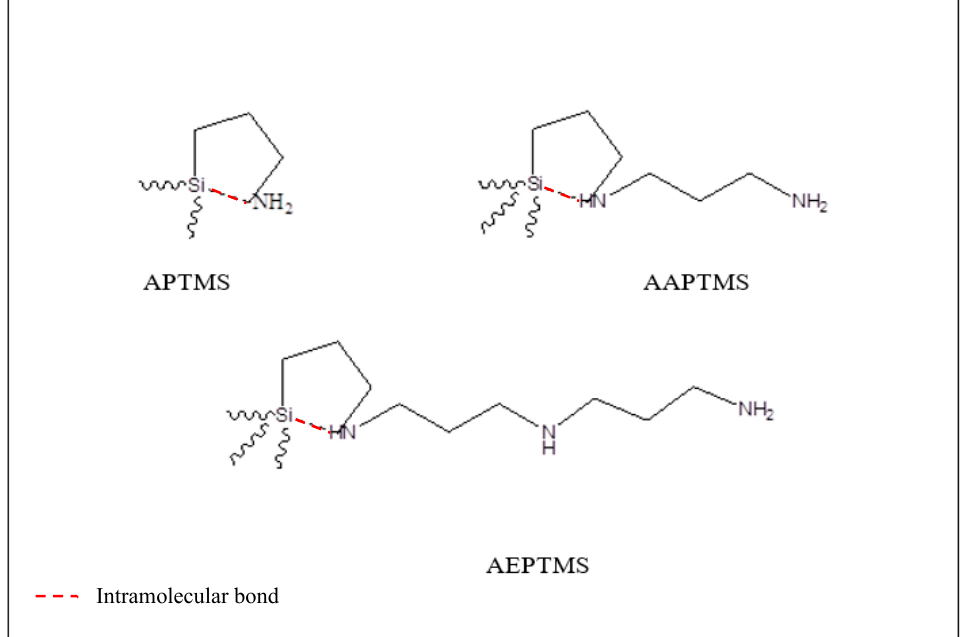
Figure 6. Intramolecular catalysis of amine-functionalization agents including APTMS (monomine), AAPTMS (diamine), and AEPTMS (triamine), adapted from Zhu et al. (2012) [56].